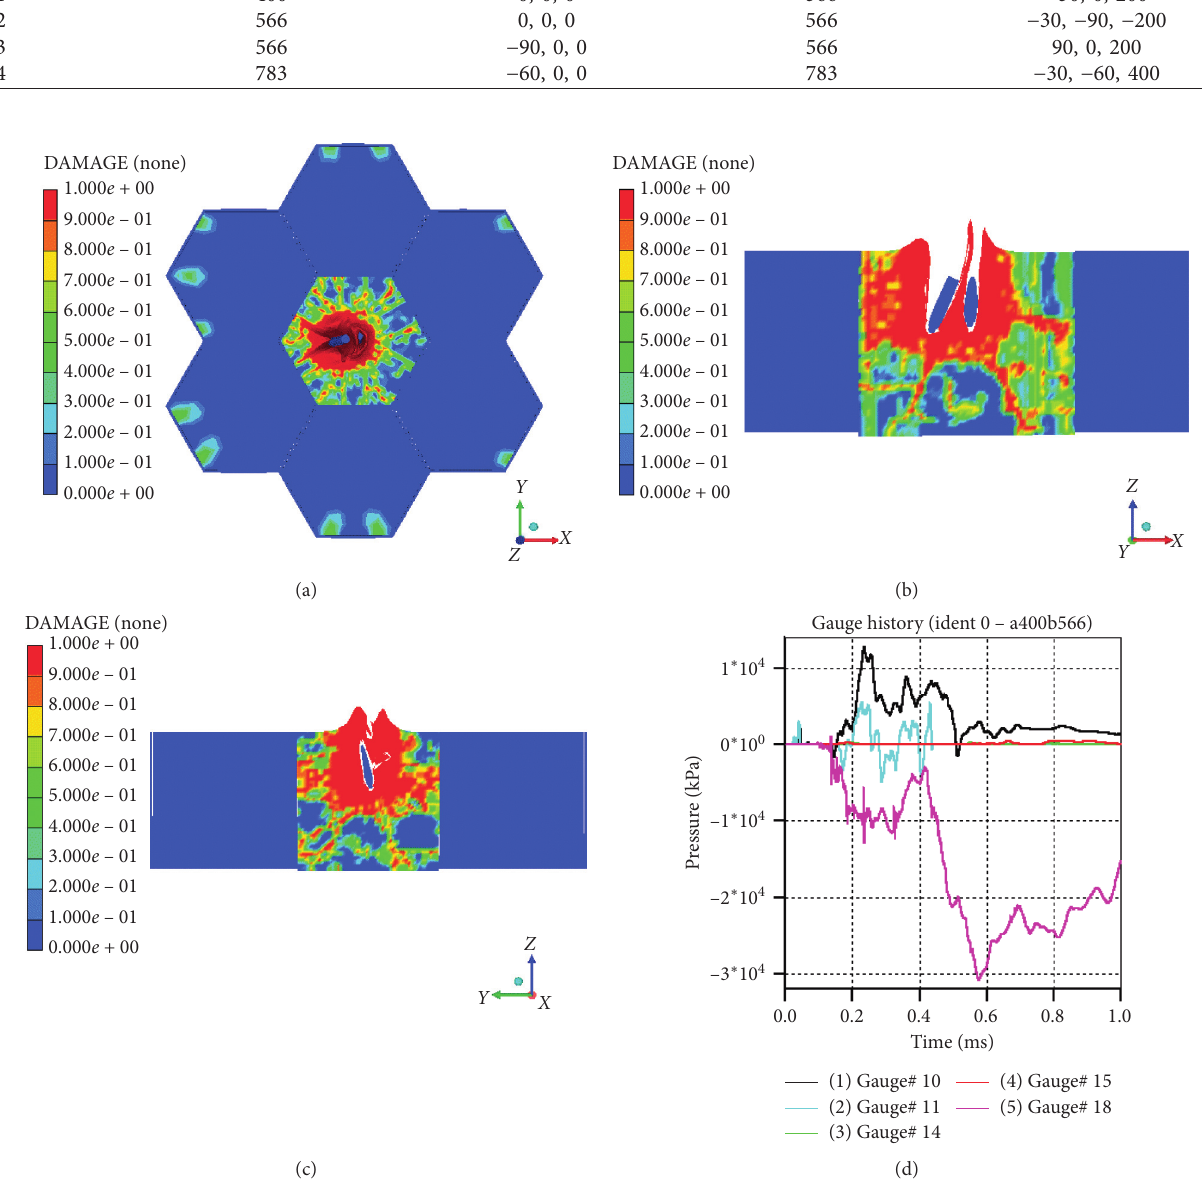
Figure 8: Target damage under configuration set 1 ( t � 1ms): (a) front view, (b) section view by XZ plane, (c) section view by YZ plane, and (d) gauge history.